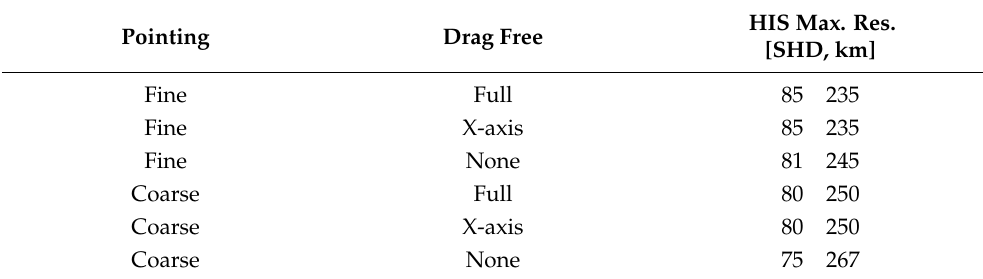
Table 5. Maximum spatial resolution of the different scenarios to fully observe the HIS signal, in spherical harmonic degree (SHD) and distance.